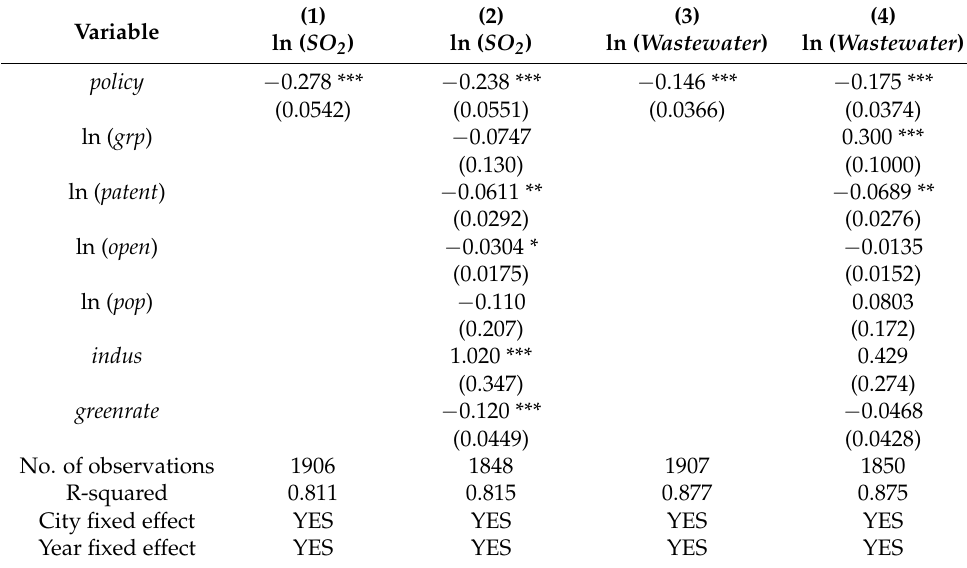
Table 4. Effect of the policy on pollution emissions (baseline